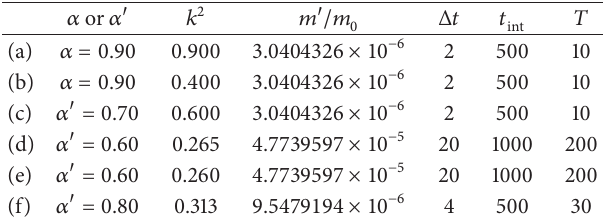
Table 1: Configuration of the numerical integration presented in Section 5. Δ𝑡 is nominal stepsize (days), 𝑡 int is interval time of output (years), and 𝑇 is total integration period (million years). The parameter combinations of 𝛼 (or 𝛼 󸀠 ) and 𝑘 2 from (a) to (f) are common to both in Figures 2, 3, 6, and